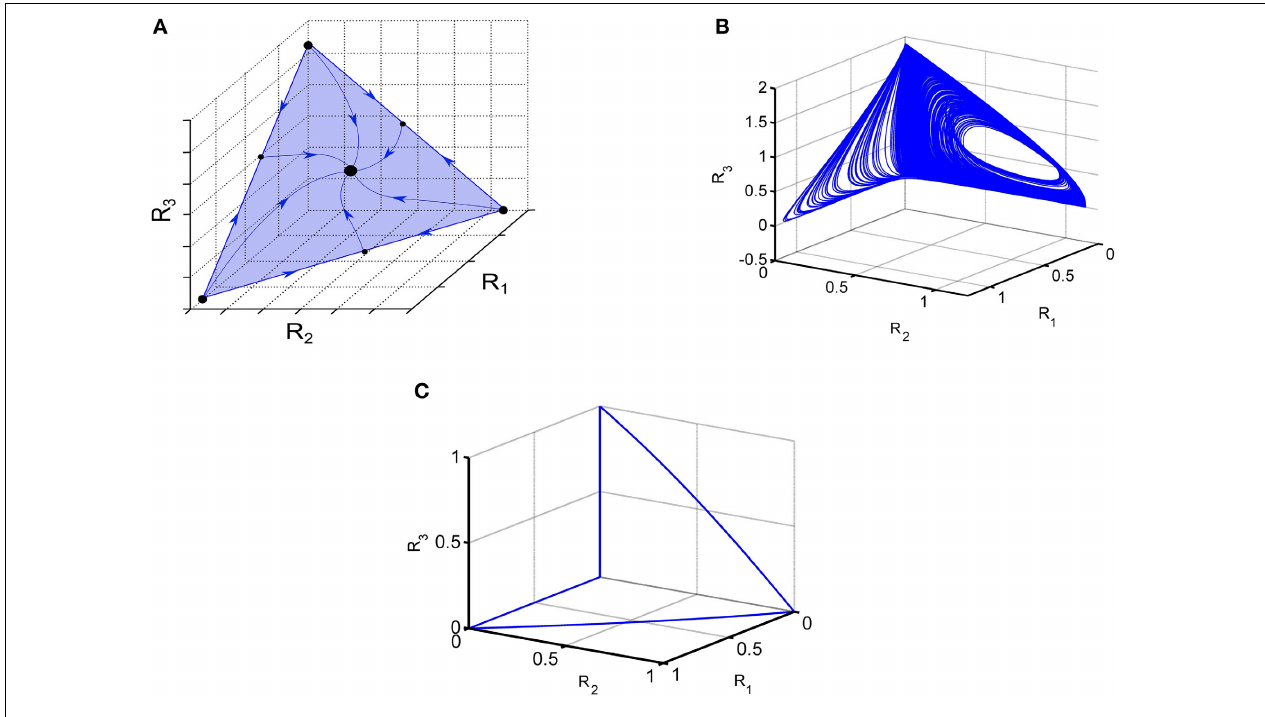
FIGURE 1 | Illustration of various dynamical regimes of the Lotka-Volterra system. (A) Example of a system when all trajectories converge to one stable fixed point, illustrating the coexistence of 3 modes. (B) Portrait of irregular switching in a 6-dimensional inhibitory LV network. 3D